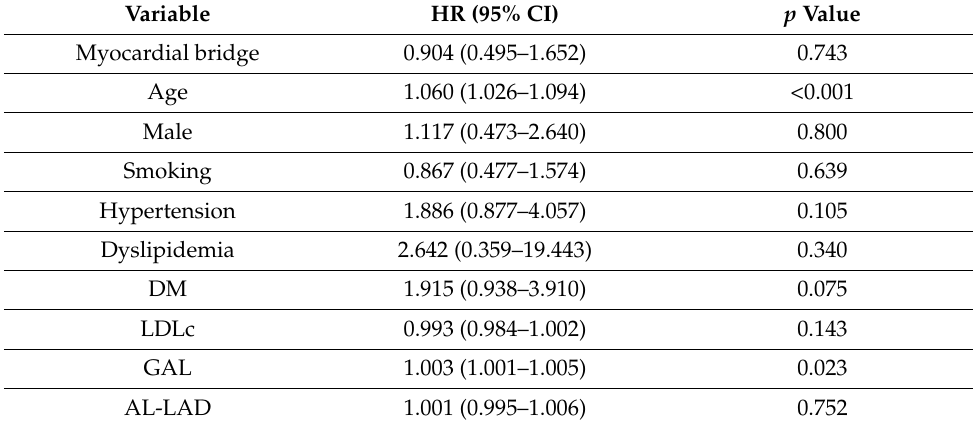
AL-LAD 1.001 (0.995–1.006)